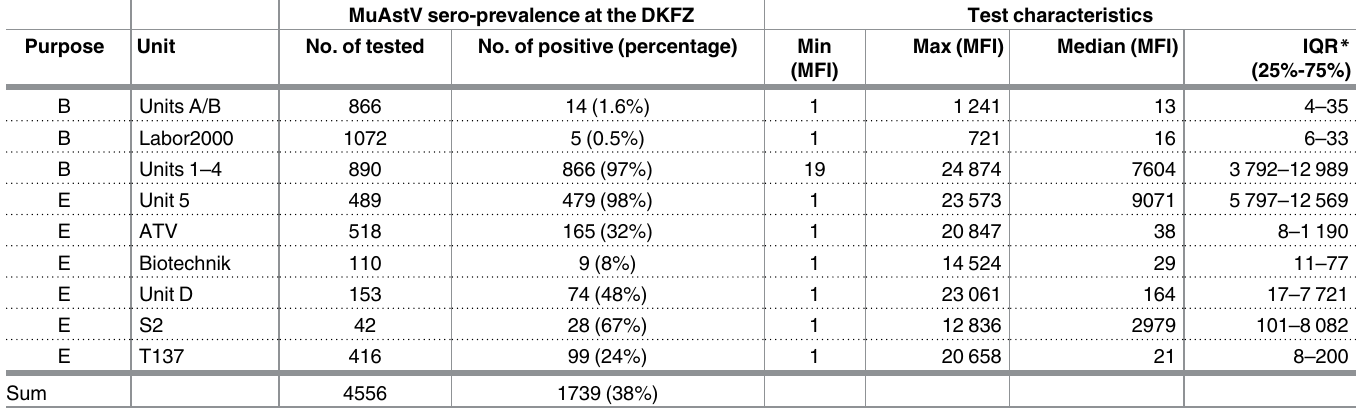
Table 2. Comparison of MuAstV antibody prevalence, antibody levels and testing characteristics between breeding and experimental units at the DKFZ. MuAstV sero-prevalence at the DKFZ Test